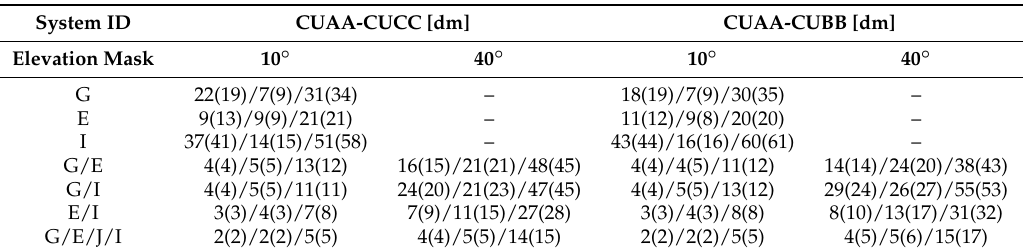
Table 3. Empirical and average formal (in brackets) standard deviations of the ambiguity-float baseline errors. The results are given in the north/east/height directions. The data on DOY 224, 2018 was used for both baselines.